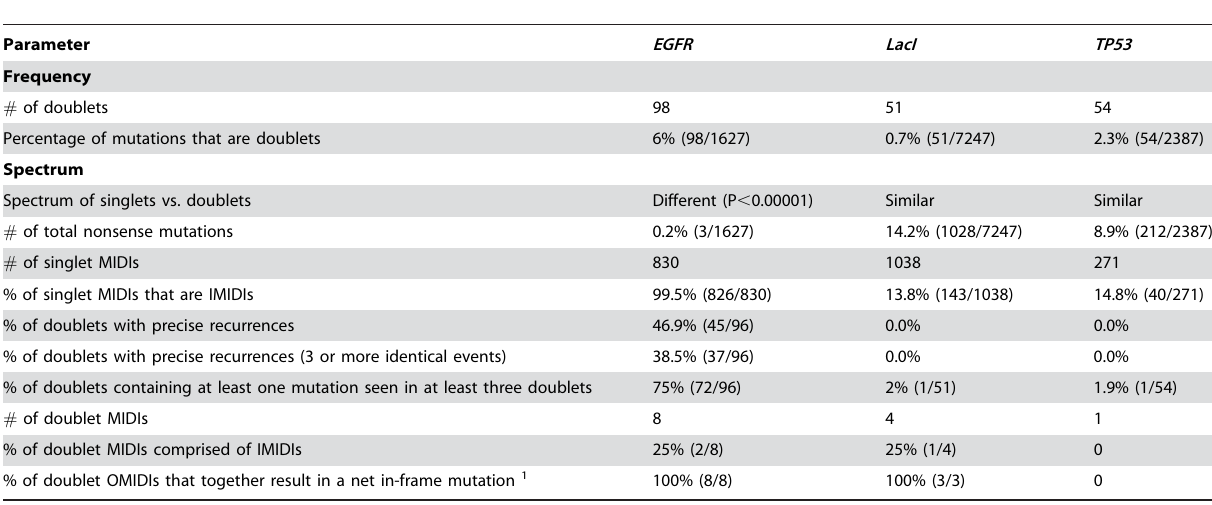
Table 2. A comparison of doublet characteristics among EGFR (lung cancer), LacI (Big Blue) and TP53 (lung cancer).